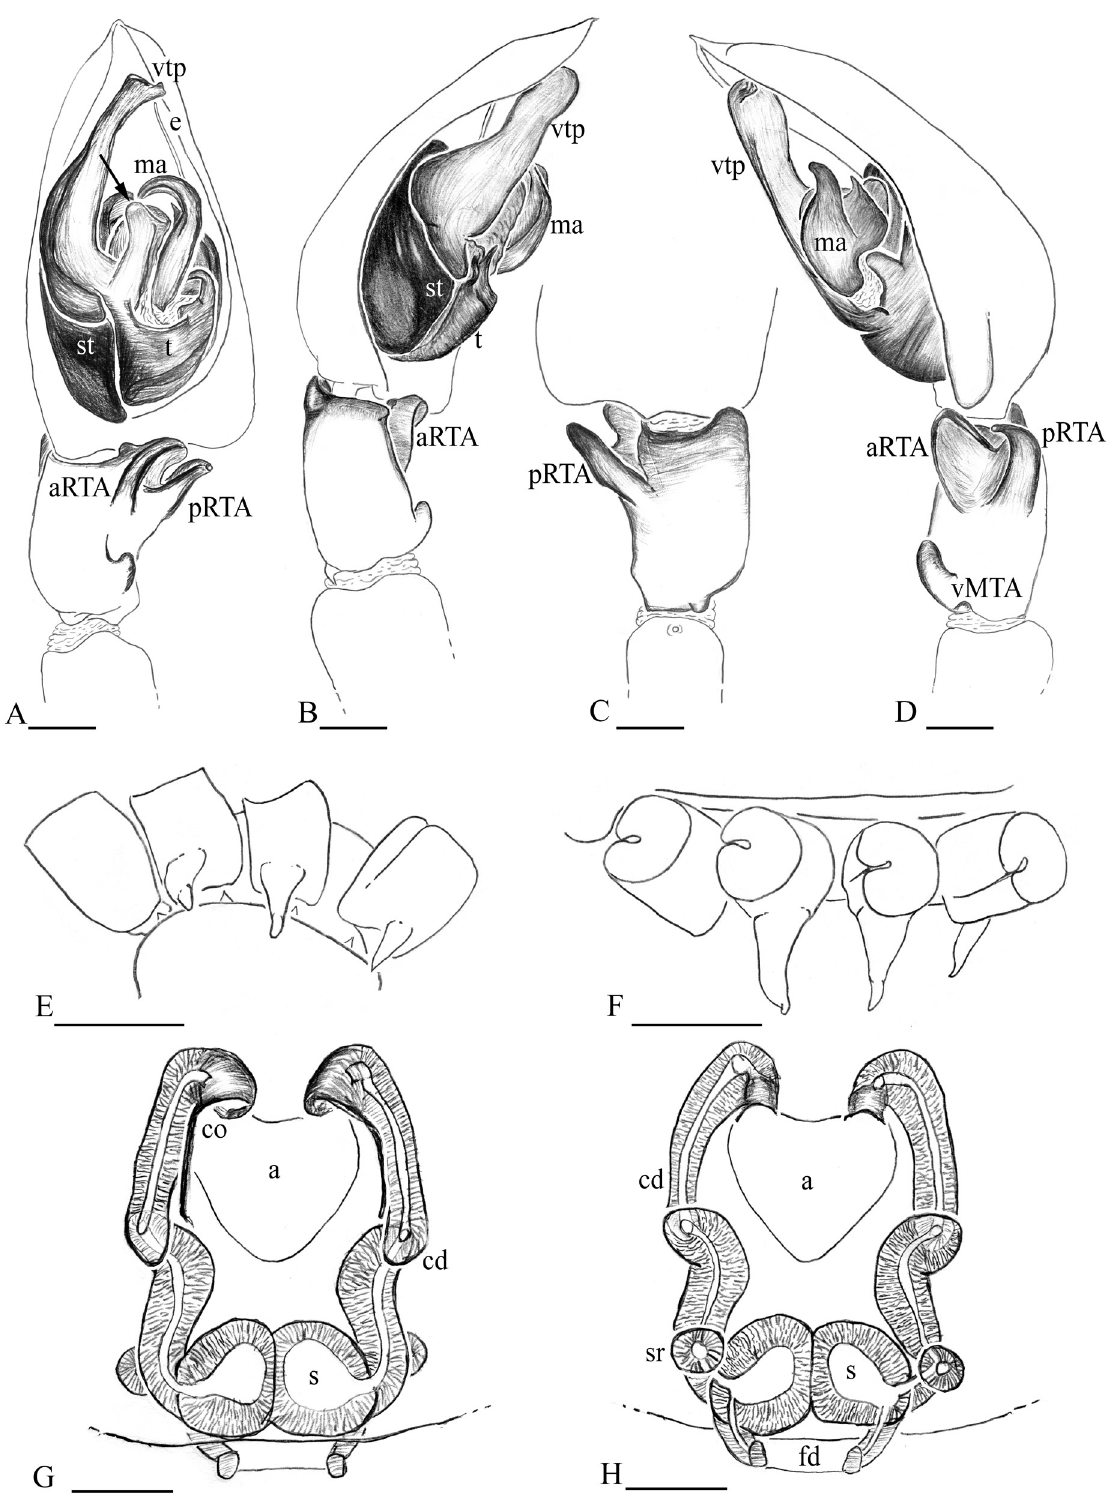
Fig. 27. Anyphaena dulceae sp. nov. A–F . Paratype, ♂ (CNAN-T01551). G–H . Paratype, ♀ (CNAN-T01552). A . Pedipalp, ventral view. B . Pedipalp, prolateral view. C . Pedipalp, dorsal view. D . Pedipalp, retrolateral view. E . Coxae, ventral view. F . Coxae, lateral view. G . Epigynum, ventral view. H . Epigynum, dorsal view. Scale bars: A–D, G–H = 0.2 mm; E–F = 1.0